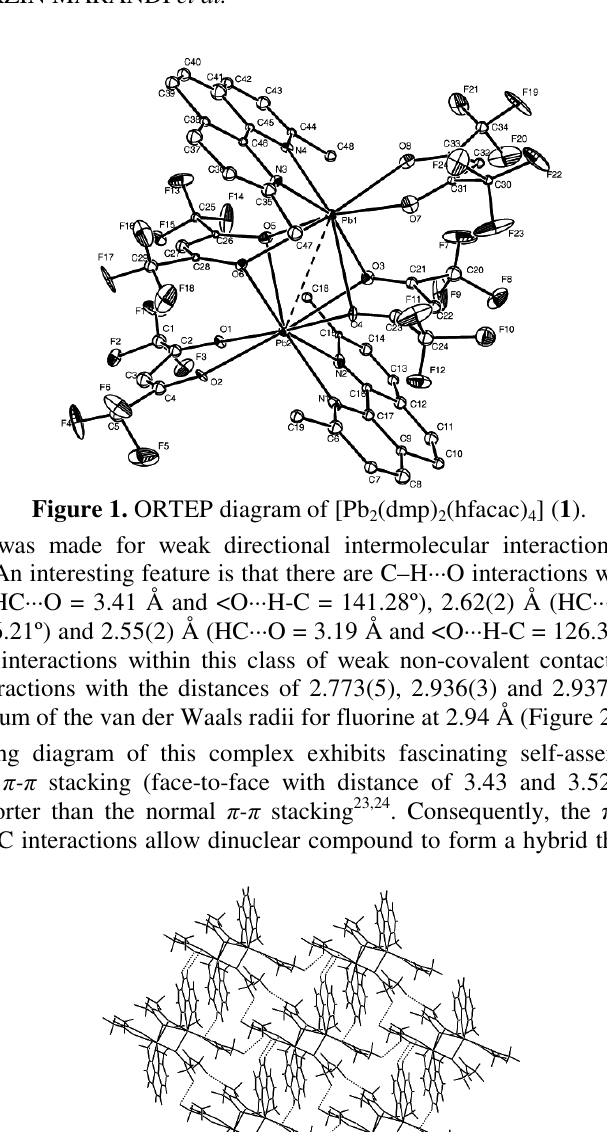
Figure 2. A view, down a , fragment of the 3D network of 1 via intermolecular